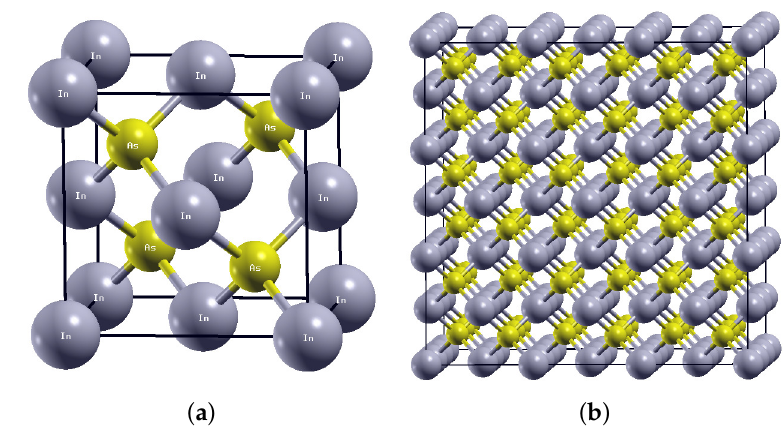
Figure 1. Atomic structures of pristine zinc blende InAs in ( a ) conventional unit cell with 4 In and 4 As atoms and ( b ) 3 × 3 × 3 super unit cell with 108 In and 108 As atoms, referenced for defect calculations. Here, the small yellow ball denotes As atoms, while the large silver balls are for In